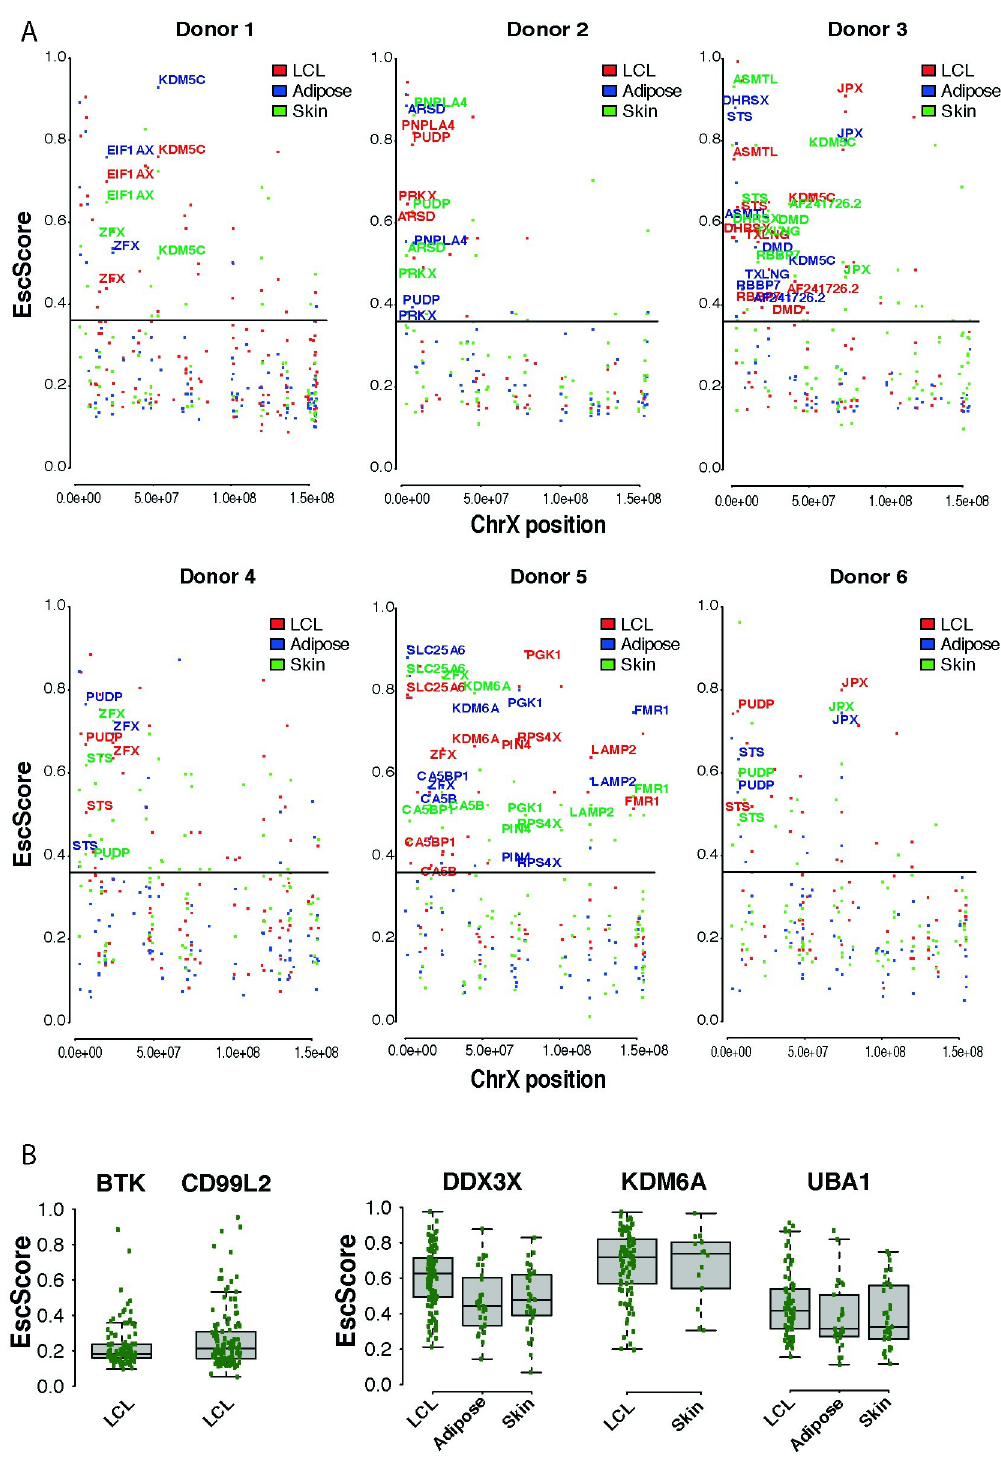
Fig 2. (A) Analysis of intra-individual EscScore variation within each of the 6 female donors exhibiting skewed XCI in all tissues. Each dot shows the gene’s EscScore in each tissue. Genes with EscScore � 0.36 in all three tissues within a donor are colored in red (LCLs), blue (adipose), green (skin). (B) Representative subset of genes to assess inter-individual variation in EscScore. Each green dot shows the gene’s EscScore in a tissue sample. BTK and CD99L2 show consistent EscScore in LCLs across individuals. DDX3X , KDM6A and UBA1 show inter-individual variability of EscScore in LCLs and a solid tissue. Similar plots for other genes are shown in S1 and S2 Figs. https://doi.org/10.1371/journal.pgen.1010556.g002 PLOS Genetics | https://doi.org/10.1371/journal.pgen.1010556 February 21,